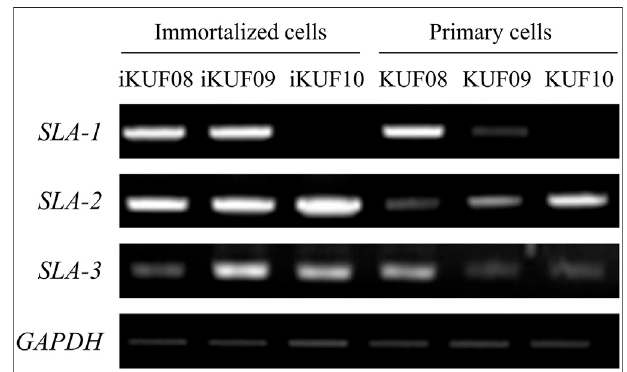
FIGURE 5 | Comparison of SLA classical class I gene expression betweenprimaryandimmortalizedcells.Threeimmortalizedcelllines,iKUF08, iKUF09, and iKUF10, are analyzed. KUF08, KUF09, and KUF10 are primary cells before immortalized. The names of the cells are on top. The expression of SLA-1, -2 , and -3 are being compared. GAPDH is used as a control. The representative image from the triplicate analysis is shown.